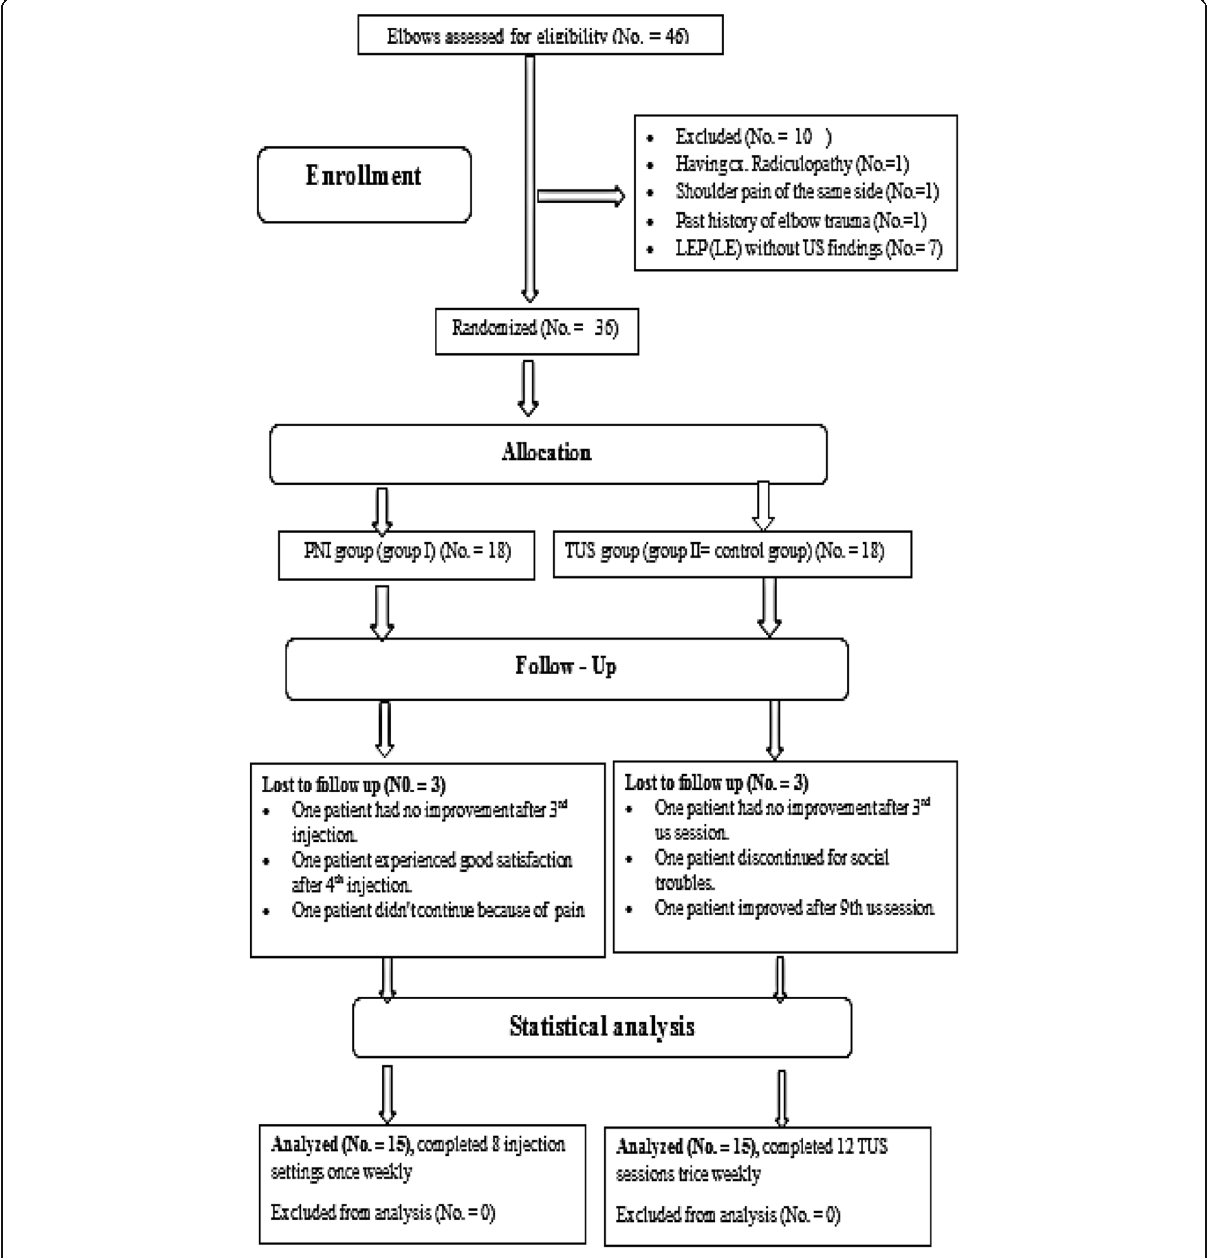
Fig. 1 The flow chart of